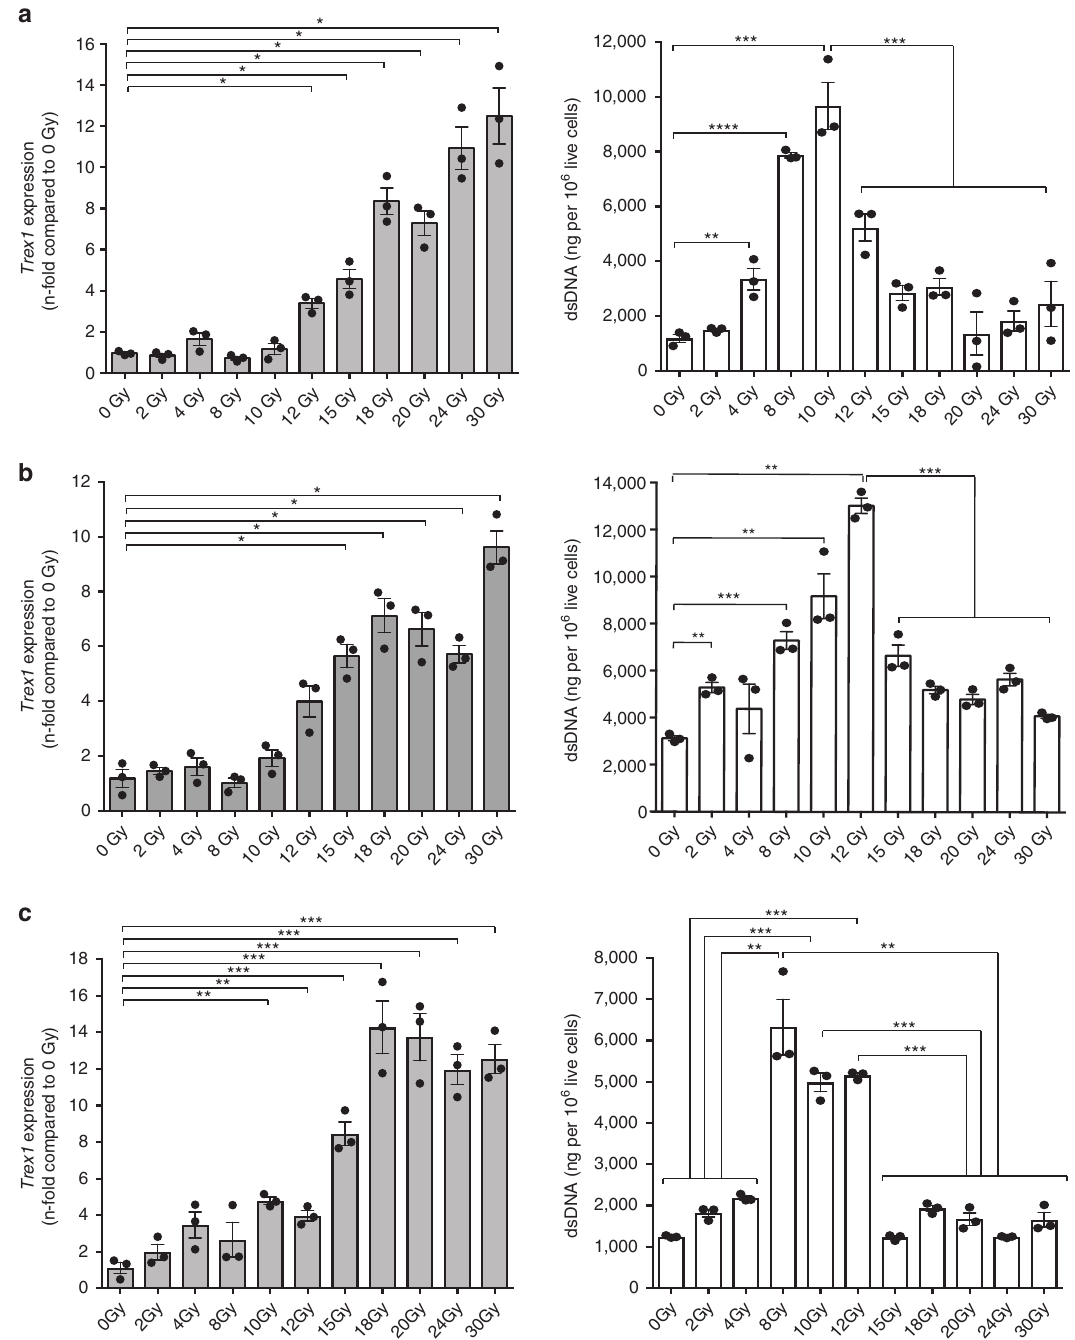
Figure 7 | Threshold for Trex1 induction by radiation in mouse cell lines. Trex1 gene expressions and cytoplasmic dsDNA accumulations in TSA ( a ), MCA38 ( b ) and 4T1 ( c ) carcinoma cells measured 24h after in vitro treatment. Duplicate; * P o 0.05; ** P o 0.005; *** P o 0.0005: t -test; n ¼ 3. All data are mean ±